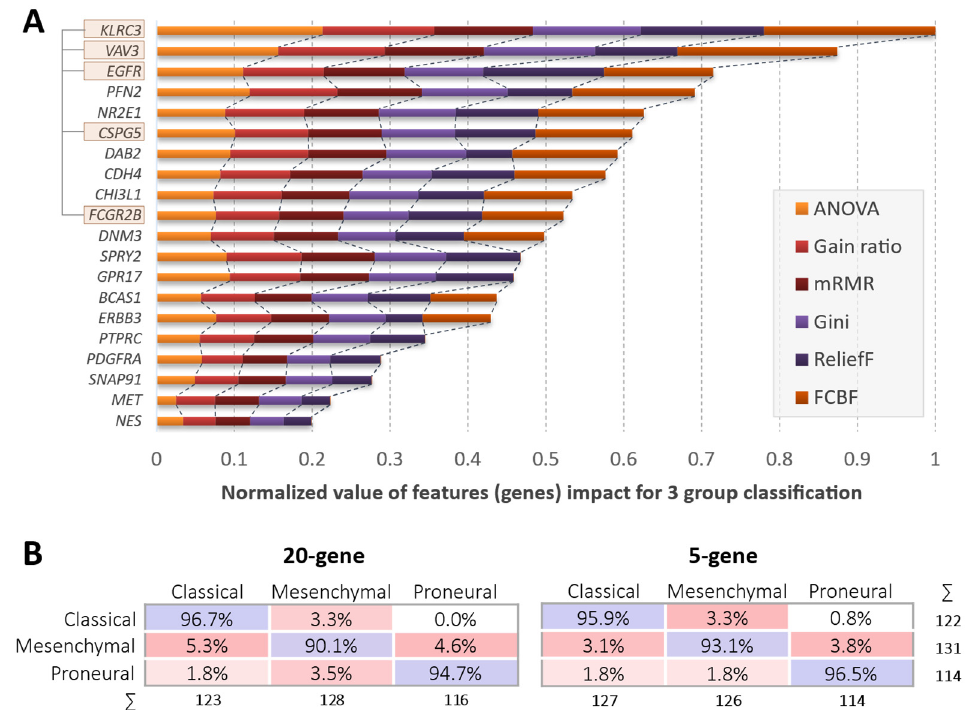
Figure 1. ( A ) Twenty genes were selected for GBM subtype classifier development, which scored the highest cumulative values regarding the feature selection methods. The values of each feature measured by the different methods were normalized to the method values mean. Genes selected for the five-gene classifiers are indicated by pink rectangles. ( B ) The comparison of 20-gene and five-gene classifiers’ classification accuracy per tumor subtype.